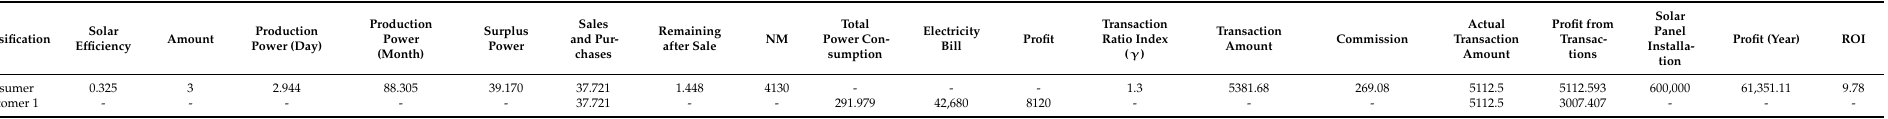
Table 3. Profits and ROI from the perspective of prosumers and customers based on simulated data of Prosumer 1 and Customer 1 (kWh, KRW).